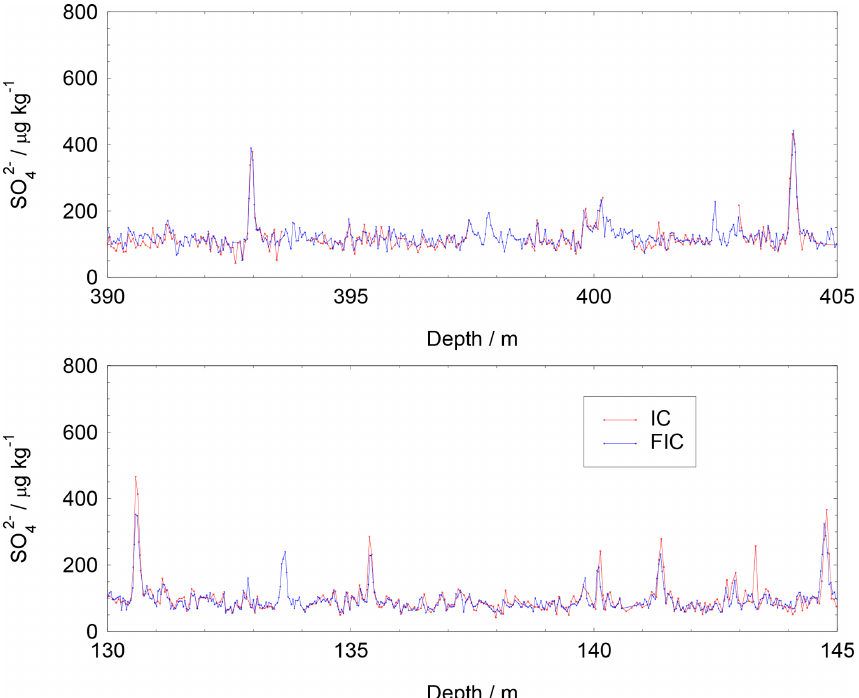
Figure 1. Comparison of FIC and IC data for two sections of the EDC ice core. In the section from 130 to 150m, FIC peaks are consistently lower than those of IC, while in the section from 390m, the concentrations are the same in the two